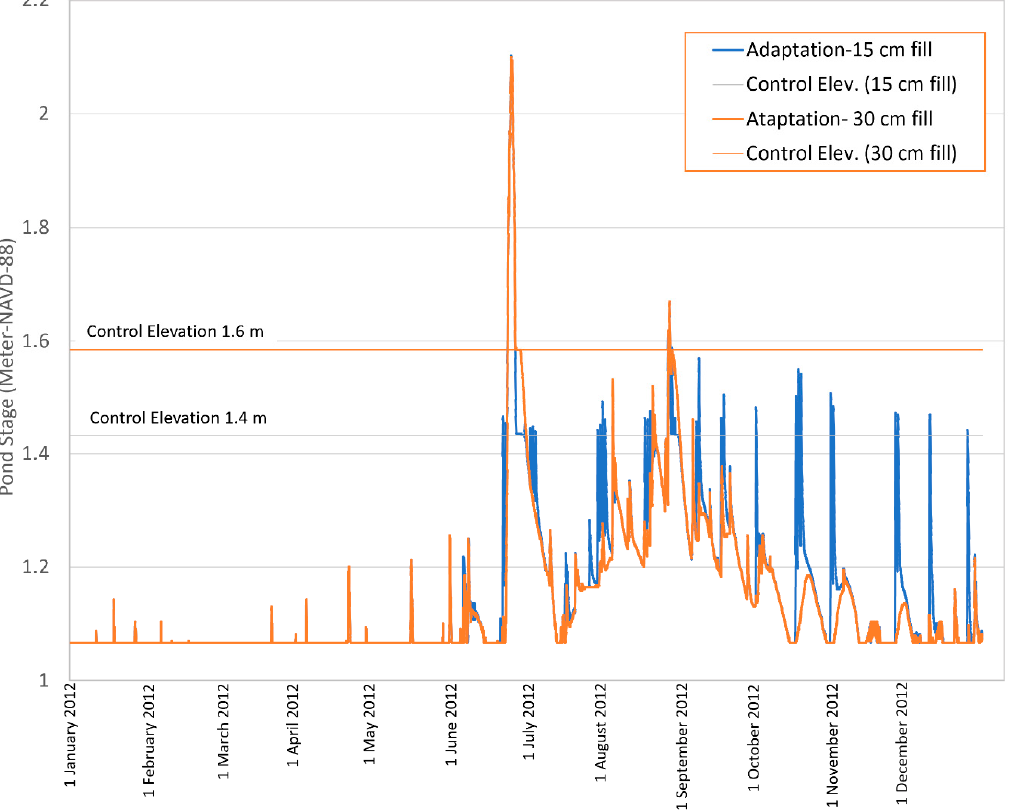
Figure 12. Pond water elevation under two different fill scenarios of 15 cm (6 inch) and 30 cm (1 foot) as adaptation options.